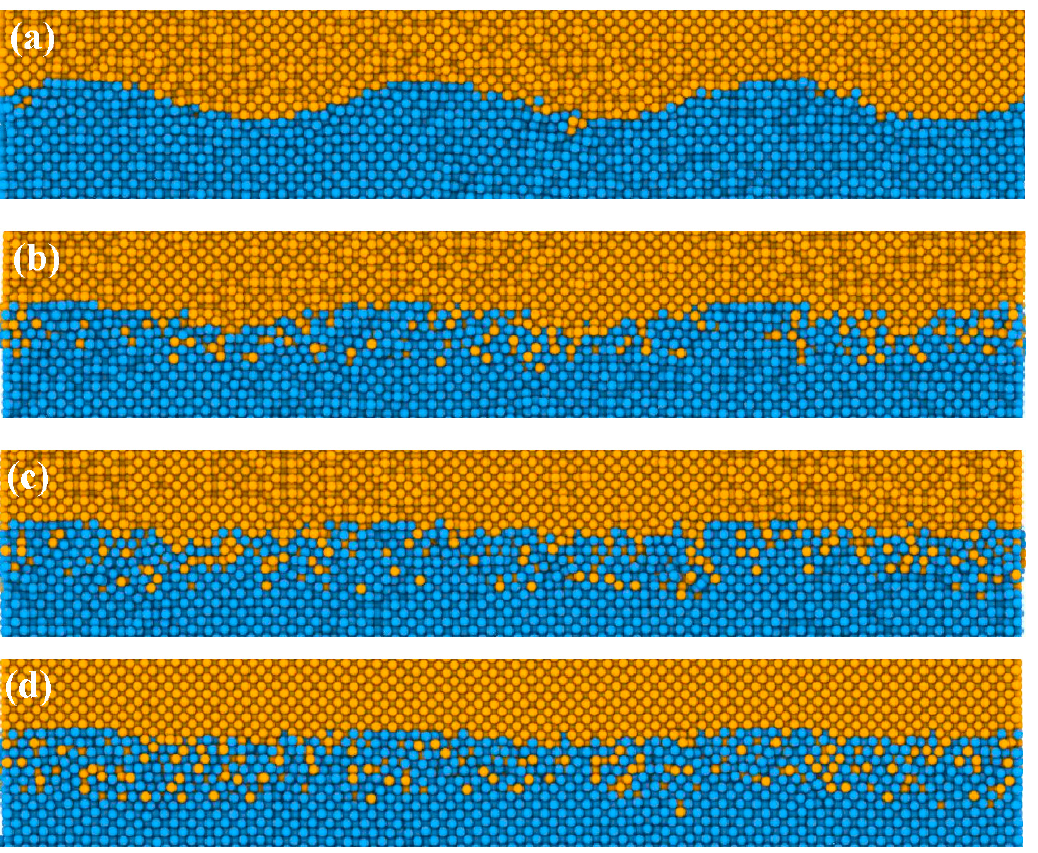
Figure 3. The cross-sectional views of the atomic configurations obtained at: ( a ) 0.1 ns, ( b ) 1 ns, ( c ) 3 ns, and ( d ) 5 ns. Only atoms near the interface are shown.